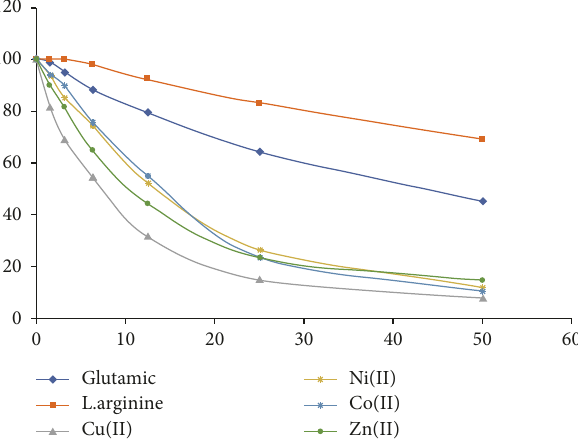
Figure 10: Cell viability of (HePG2) at different concentrations of ligands and the prepared metal complexes. Table 7: Simulated electrical properties of complexes studied exhibiting enhanced inhibition of HePG2.